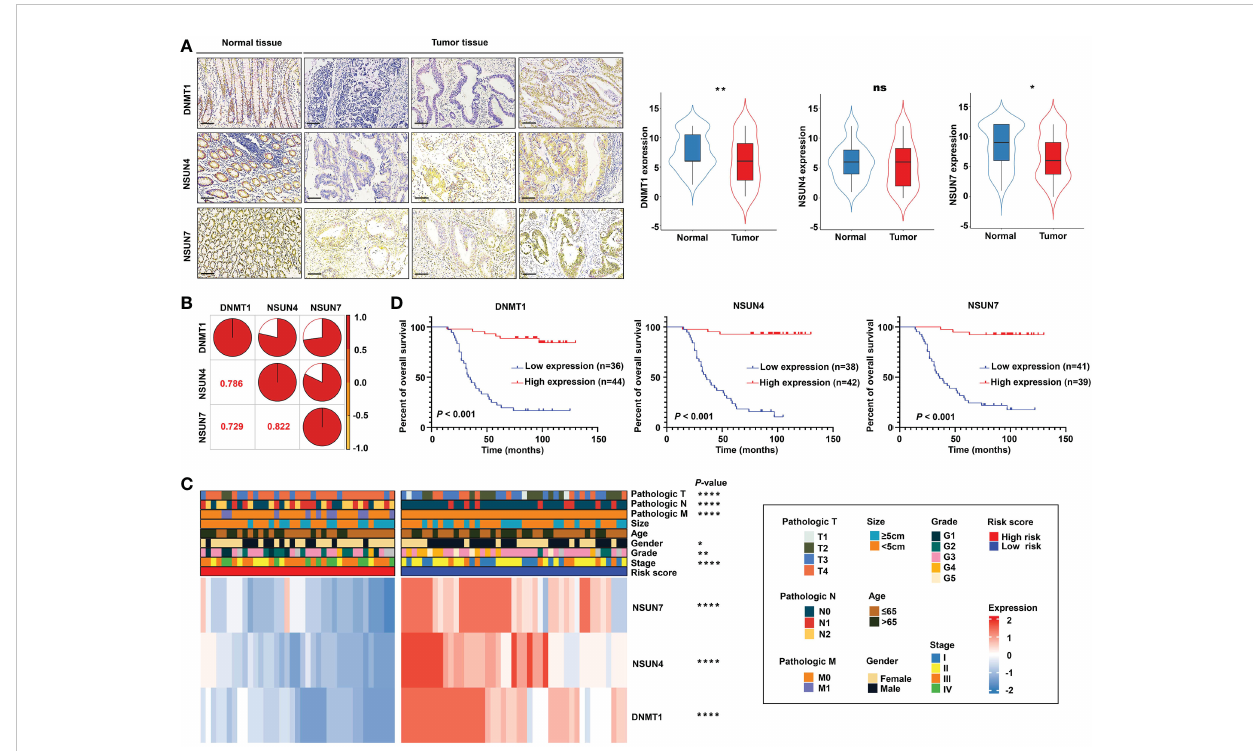
FIGURE 10 Validation of the m 5 C methylation – based signature by rectal cancer tissue microarray (TMA). (A) The differential expression of NSUN4, NSUN7, and DNMT1 between normal and tumor tissue; the representative micrographs show NSUN4, NSUN7, and DNMT1 IHC staining of 80 pairs of rectal cancer and corresponding normal rectal tissue samples in the rectal cancer TMA. (B) The correlation among the expression levels of NSUN4, NSUN7, and DNMT1. (C) The heat map depicting the association of the risk score, gene expression, and clinicopathological parameters. (D) Kaplan – Meier curves of differential NSUN4, NSUN7, and DNMT1 expression in the TMA cohort of rectal cancer. **** P < 0.0001; ** P < 0.01; * P < 0.05; ns, not signi fi